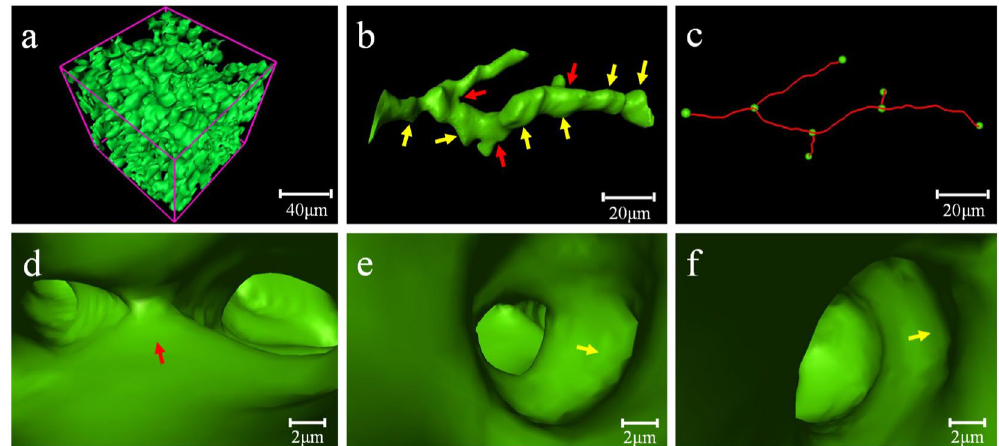
Figure 4. 3D reconstruction of ductular proliferation and VME to 3D track targeted BD. ( a ) Local 3D reconstruction of proliferative BDs. ( b ) A single segmented BD. Bifurcations in ( b) and ( d ) (red arrows), and the corrugations in ( b ), ( e ) and ( f ) (yellow arrows) are discernible. ( c ) Centre line of the segmented BD in ( b ). The branching points and breakpoints are marked by green dots. Successive pathway tracing is shown in ( d ) to ( f